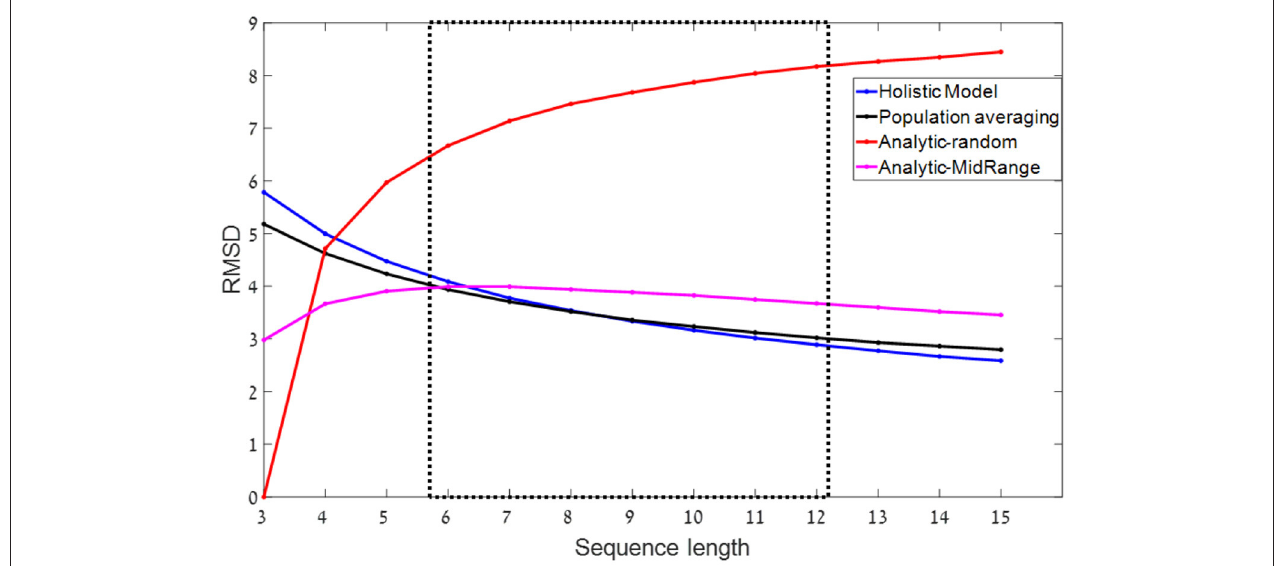
FIGURE 2 | RMSD (root mean square deviations) as a function of sequence length- predictions for different models. The dashed rectangle indicates the relevant range of sequence-lengths in our experiments. In all simulations, sets of n numbers in the range of 0–100 are sampled from a uniform distribution. Blue and black: Normative-holistic and population averaging models. Both models show similar predictions in which accuracy improves as sequence length increases. Red: Analytic-random model with k 3. Accuracy deteriorates as sequence length increases. Magenta: Mid-range model. Non-monotonic function. Shows a mild = improvement as sequence length increases in the relevant experimental